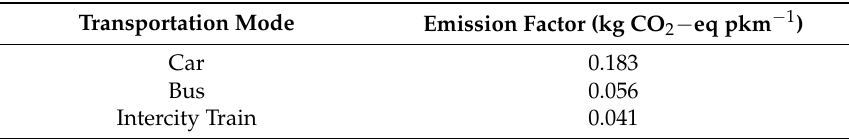
Table 3. Emission factors for each transportation mode analysed.